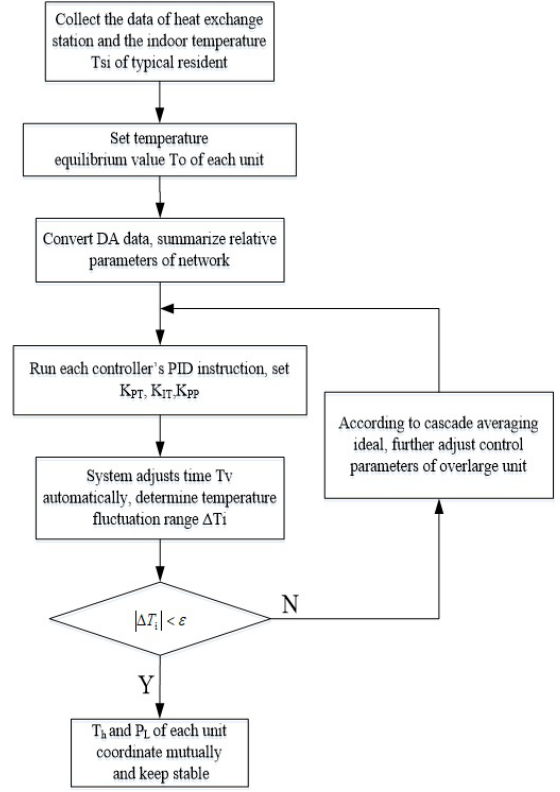
Fig. 7 System operation flow chart.